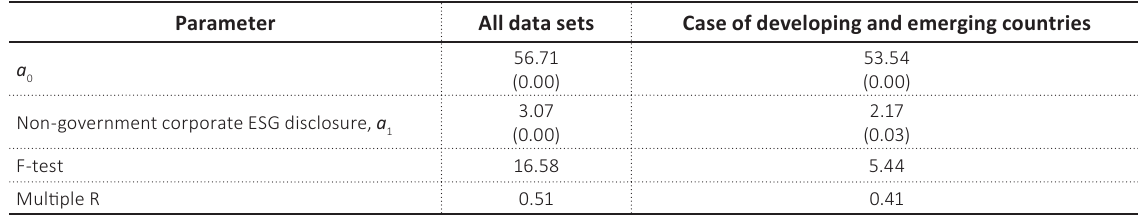
Table 6. Multiple regression analysis: SDGI score (Y) and non-government corporate ESG disclosure regulation (X)